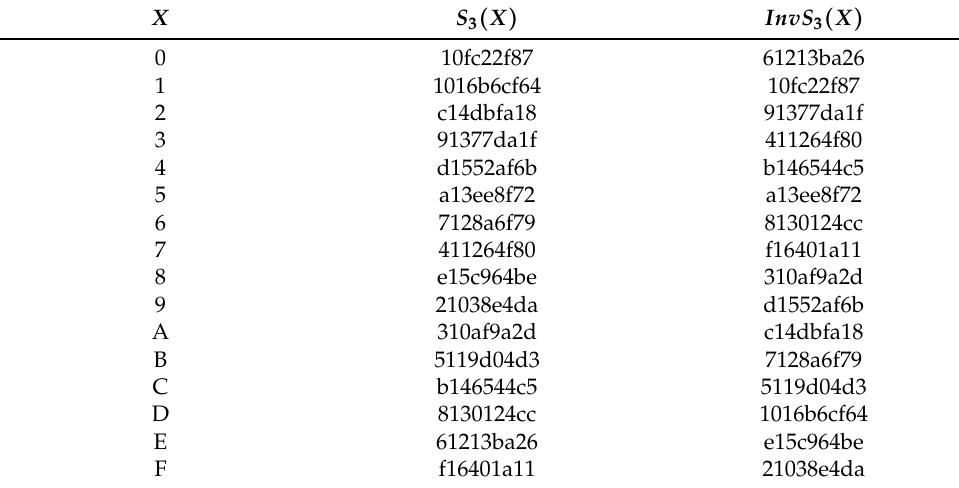
Table 13. New generated 32-bit output S-Box to replace Table 4.